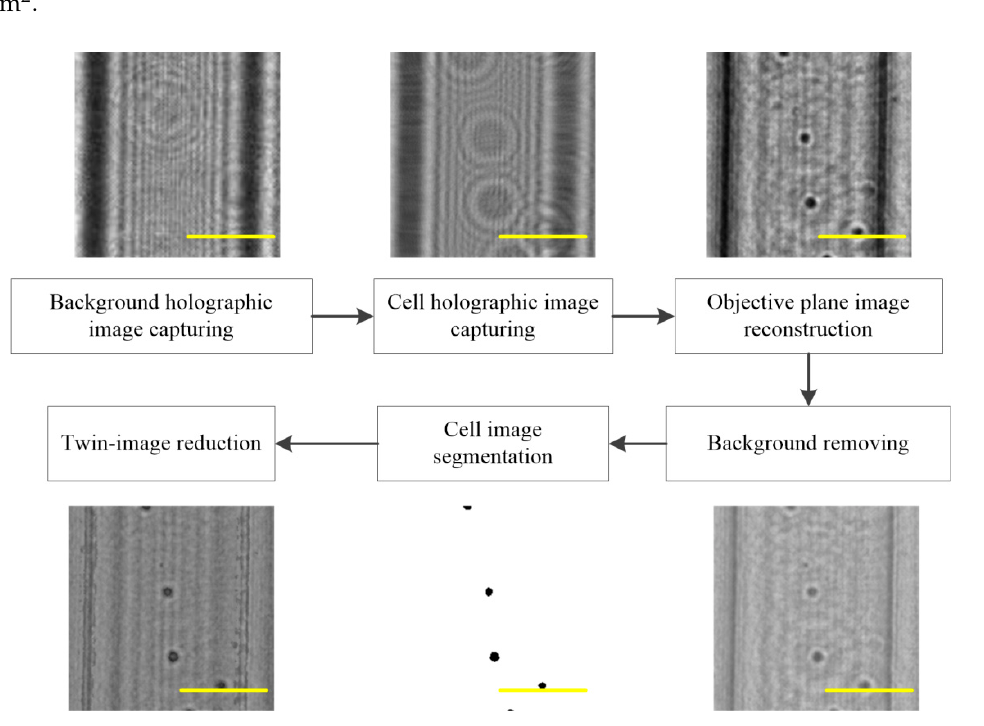
Figure 8. The reconstruction of the focus cell images flow path. To better observe the effect of holographic image reconstruction, which is a small segment of the whole image, all scale bars indicate 100 μ m.